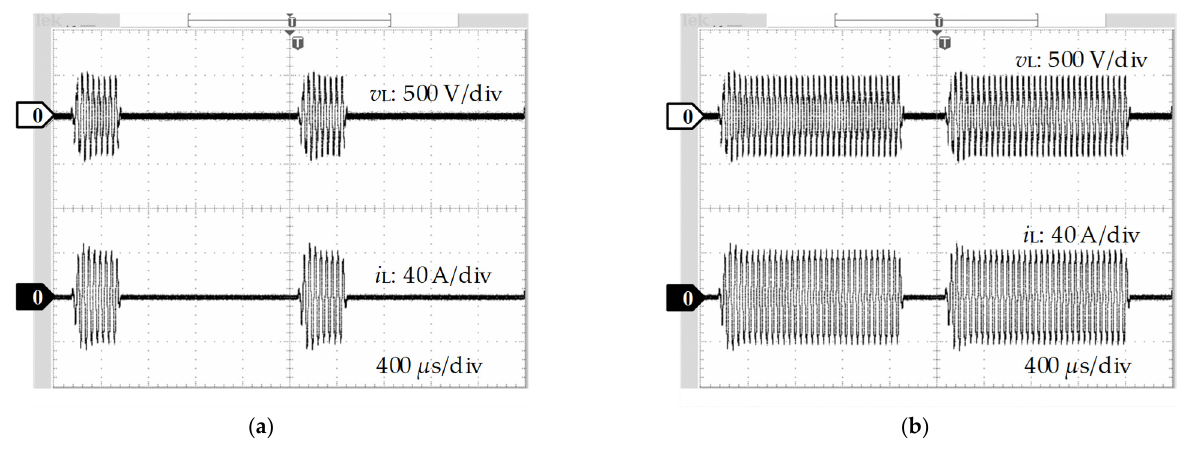
Figure 7. Load current i L and voltage v L waveforms under PDM. ( a ) Duty ratio D PDM = 0.2. ( b ) Duty ratio D PDM = 0.8.